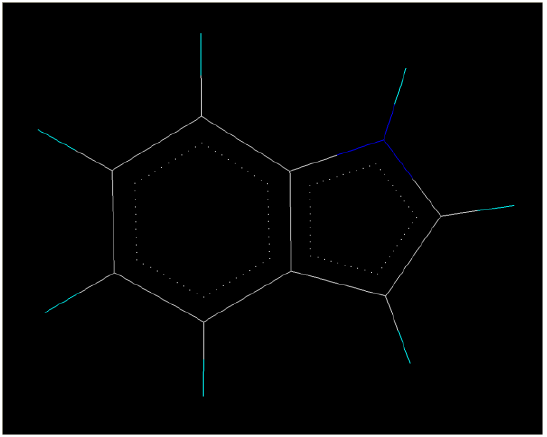
Figure 1 Basic template for